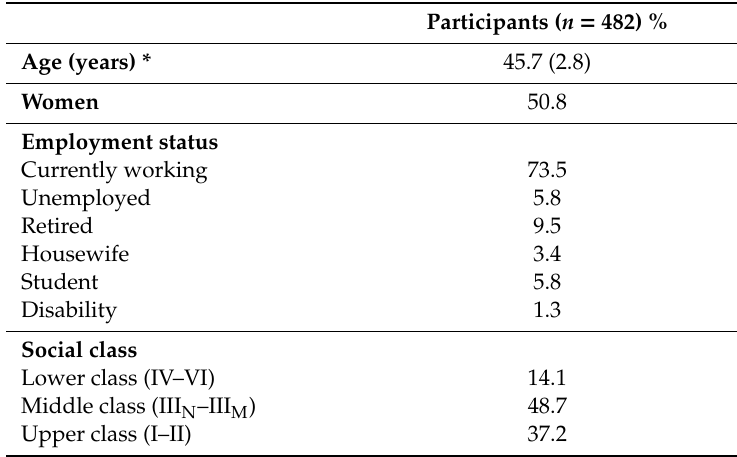
Table 1. Sociodemographic characteristics of